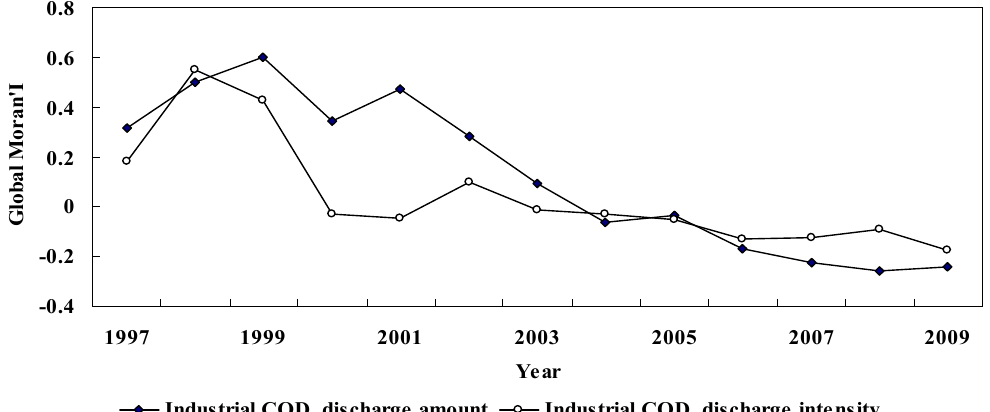
Figure 3. Global Moran’s I of industrial COD discharge amount and